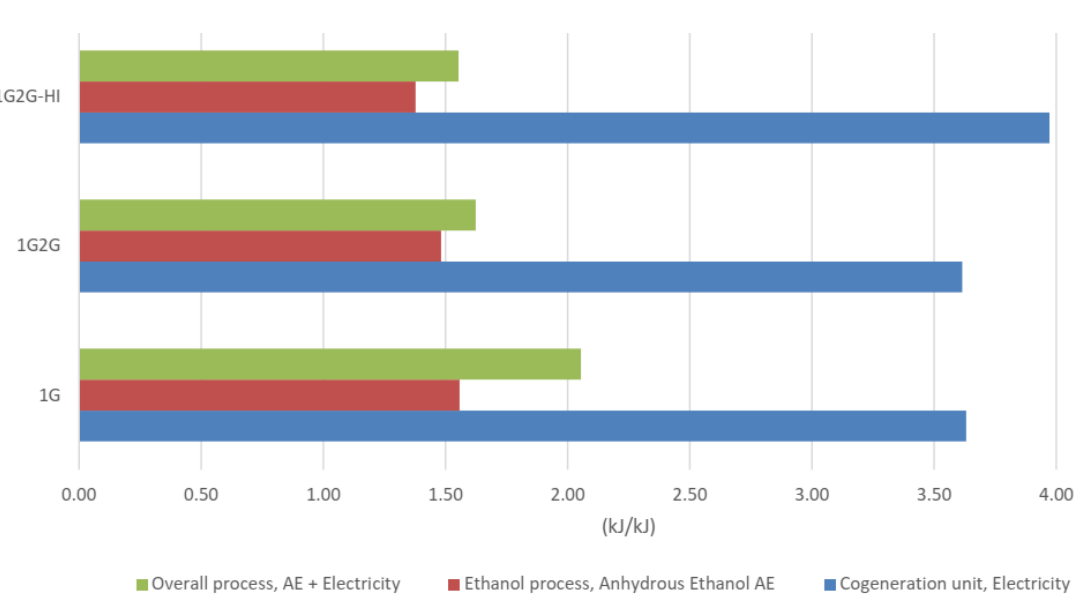
Figure A4. Average unitary exergy cost (AUEC) of each configuration. Table A10. Unit exergy cost and exergy e ffi ciency